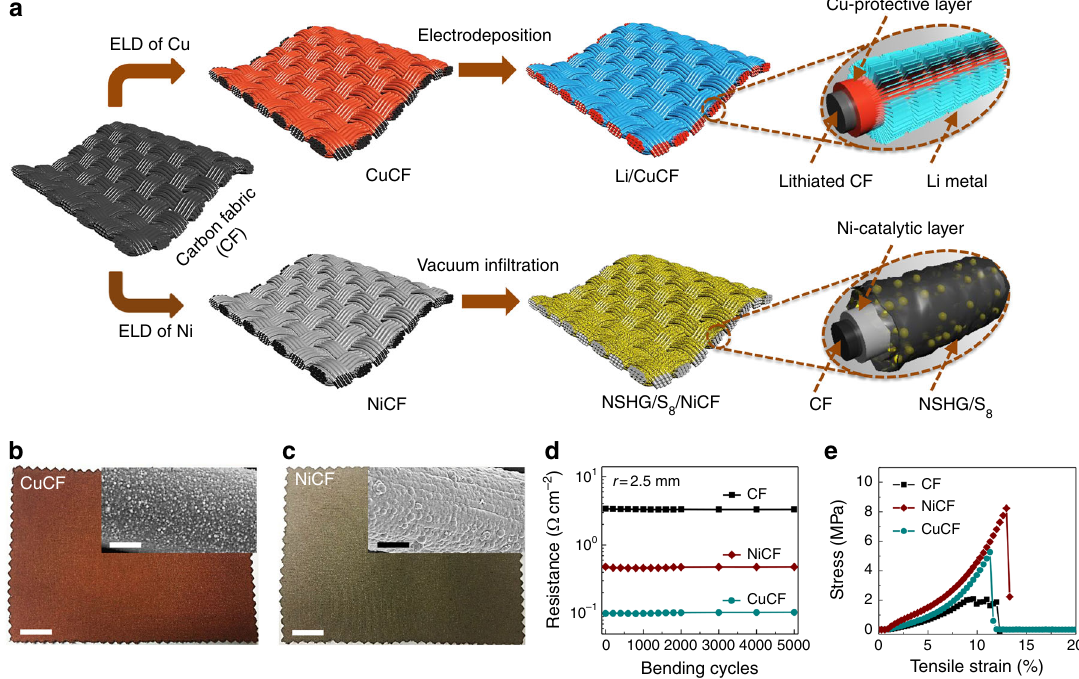
Fig. 1 Schematic of the fabrication process and design principle for the electrodes. a To simultaneously endow mechanical durability and cycling stability of Li-S batteries, chemically stable and highly conductive Cu or Ni thin layers are uniformly coated onto carbon fabrics (CuCF or NiCF) via a scalable polymer- assisted metal deposition (PAMD) method. After electrodeposition, the achieved Li/CuCF anode with Cu-protective layers and lithiated carbon could stabilize Li metal deposition and offset the irreversible Li loss during plating/stripping process. After vacuum in fi ltration, the NSHG/S 8 /NiCF cathode (NSHG is nitrogen and sulfur heavily doped graphene) with Ni-catalytic layers could simultaneously speed up the redox kinetics of soluble polysul fi des and solid Li 2 S. b , c Digital images of scalable CuCF and NiCF (scale bar = 3 cm). The corresponding enlarged metallic fi bers are also observed using scanning electron microscopy (SEM) images, as shown in the inset (scale bar = 3 µ m). d Sheet resistances of various fabrics (CF, CuCF, and NiCF) as a function of bending cycles at a given bending radius ( r = 2.5 mm). e Typical tensile stress-strain curves of CF, CuCF, and NiCF. (ELD is electroless